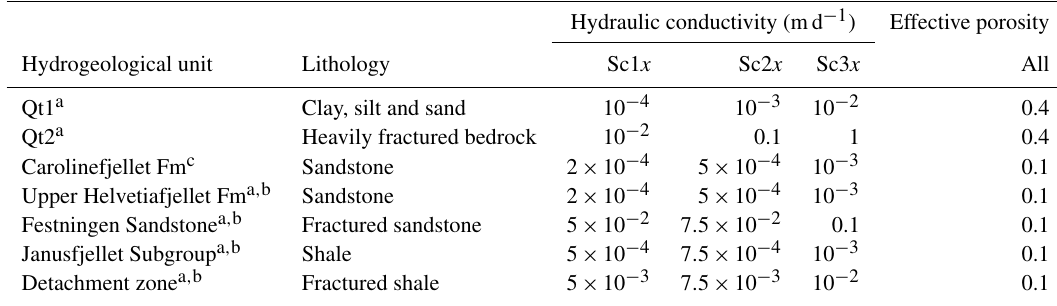
Table 3. Properties of the hydrogeological units used in the groundwater